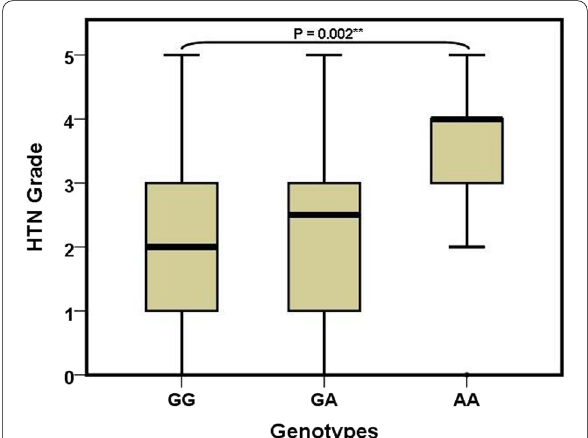
CKD, chronic kidney disease; Hypertension grades are numbered 0 (none) through 5 (most severe); S., serum; GFR-EPI, glomerular filtration rate by CKD epidemiology collaboration equation; iPTH, intact parathyroid hormone; iFGF23, intact fibroblast growth factor 23; WBCs, white blood cells; k, one thousand; ANOVA, analysis of variance; KWH, Kruskal–Wallis H Test Data are expressed as either mean SD or median (interquartile range), *: significant ( P < 0.05), **: highly significant ( P < 0.01) ±